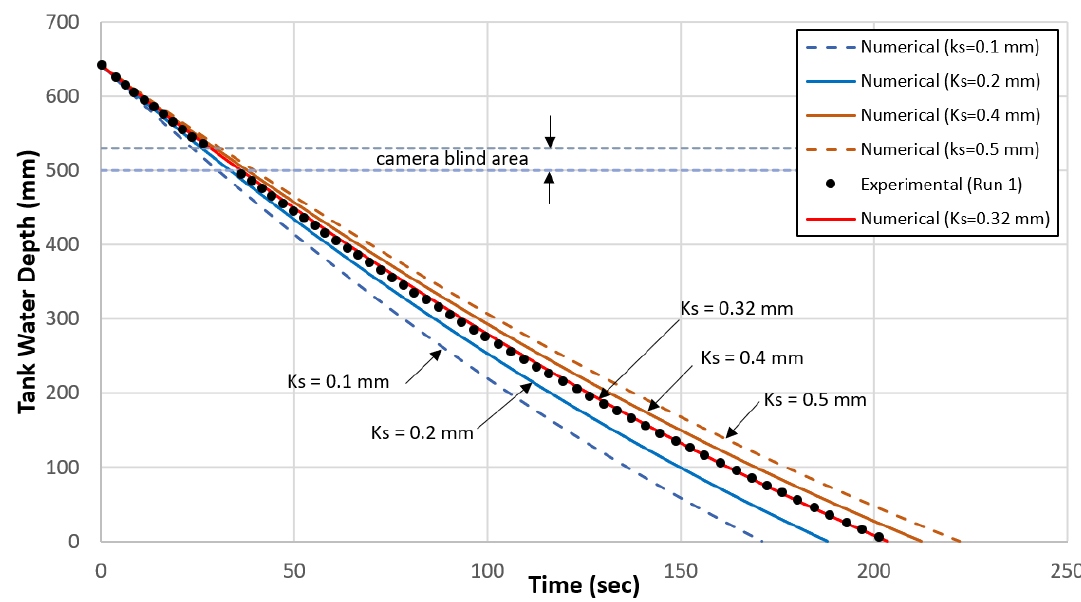
Figure 4. System calibration (run 1 with no rotor).